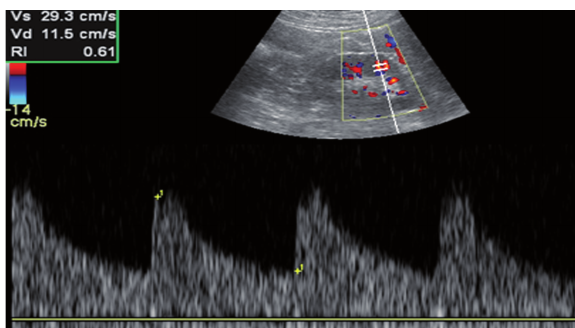
Figure 3 - Doppler waveform and measurement of RI for the intrarenal artery.